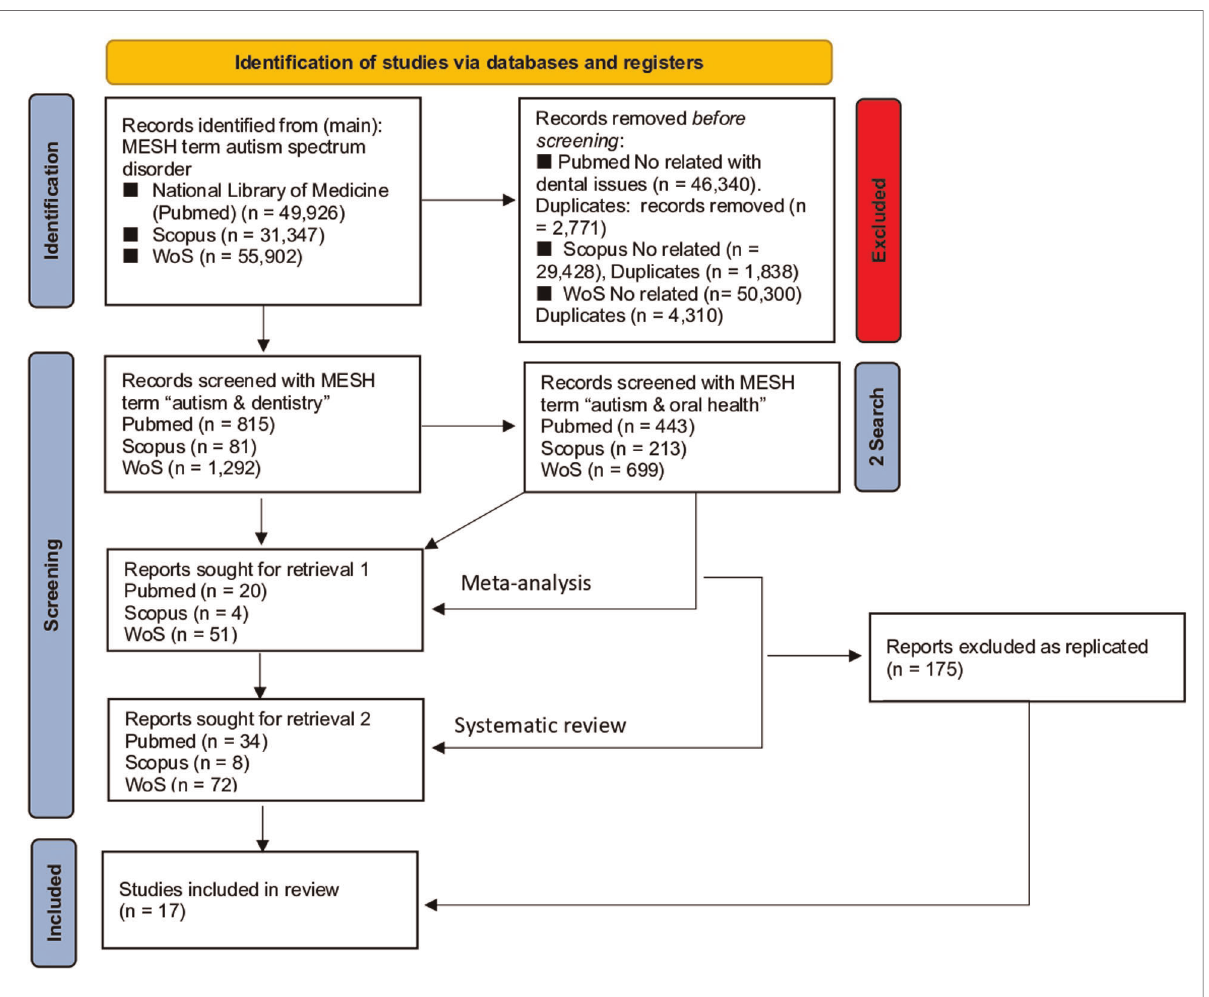
FIGURE 1 PRISMA model of our research study. See text for